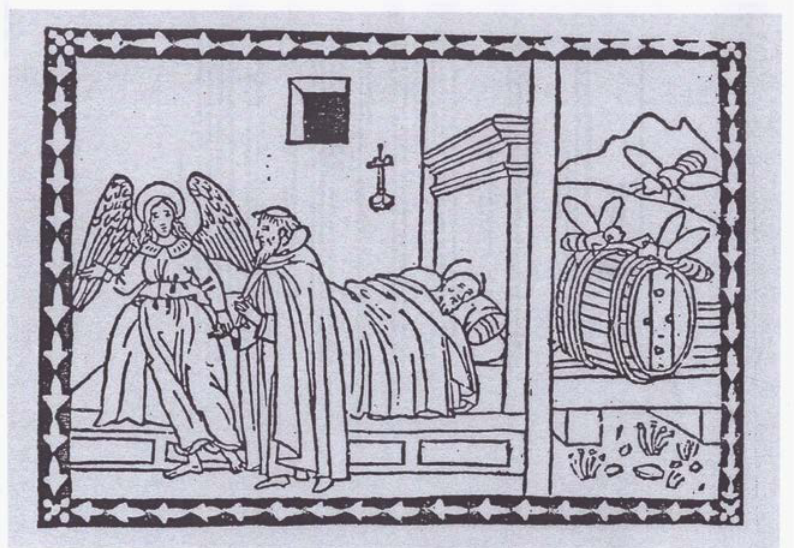
Figure 20 – Bernardo Pulci, La Rapresentatione divota di Barlaam et Iosafat , s.n.t. [but Firenze, Miscomini, around 1495], f. a8r (BNCF, Banco Rari 189.e). By permission of Ministero per i beni e le attività culturali / Biblioteca Nazionale Centrale. Firenze